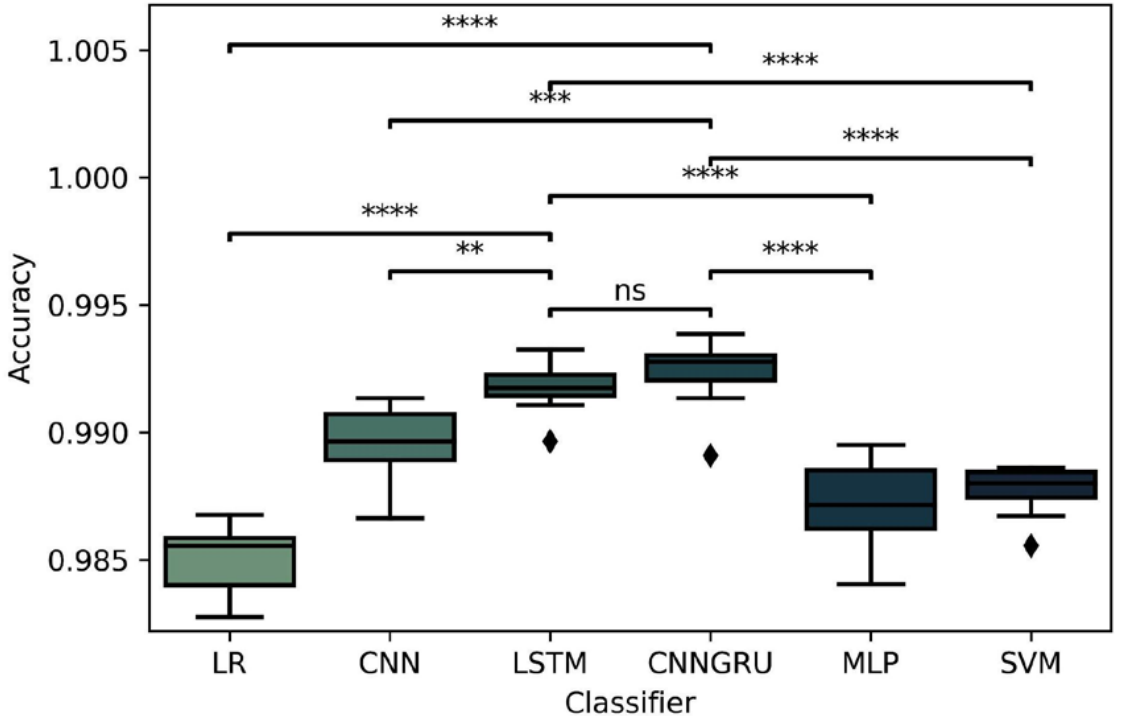
Figure 6. Comparison of the classifiers logistic regression (LR), convolutional neural network (CNN), long short-term memory (LSTM), CNN+ gated recurrent unit (CNNGRU), multilayer perceptron (MLP) and support vector machine (SVM); p -value annotation legend: ns: nonsignificant; ** p < 0.01, *** p < 0.001, **** p < 0.0001. Diamonds points represent outliers.